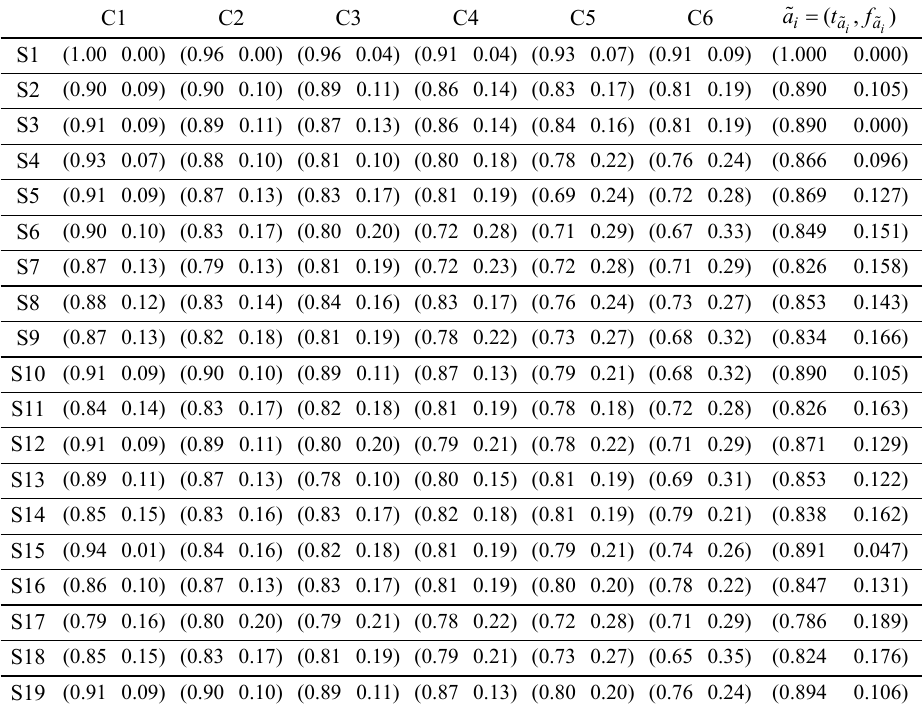
Table 6. IFVs decision matrix of strategies after reordering and their overall values (  ) based on total supply chain perspective i a C1 C2